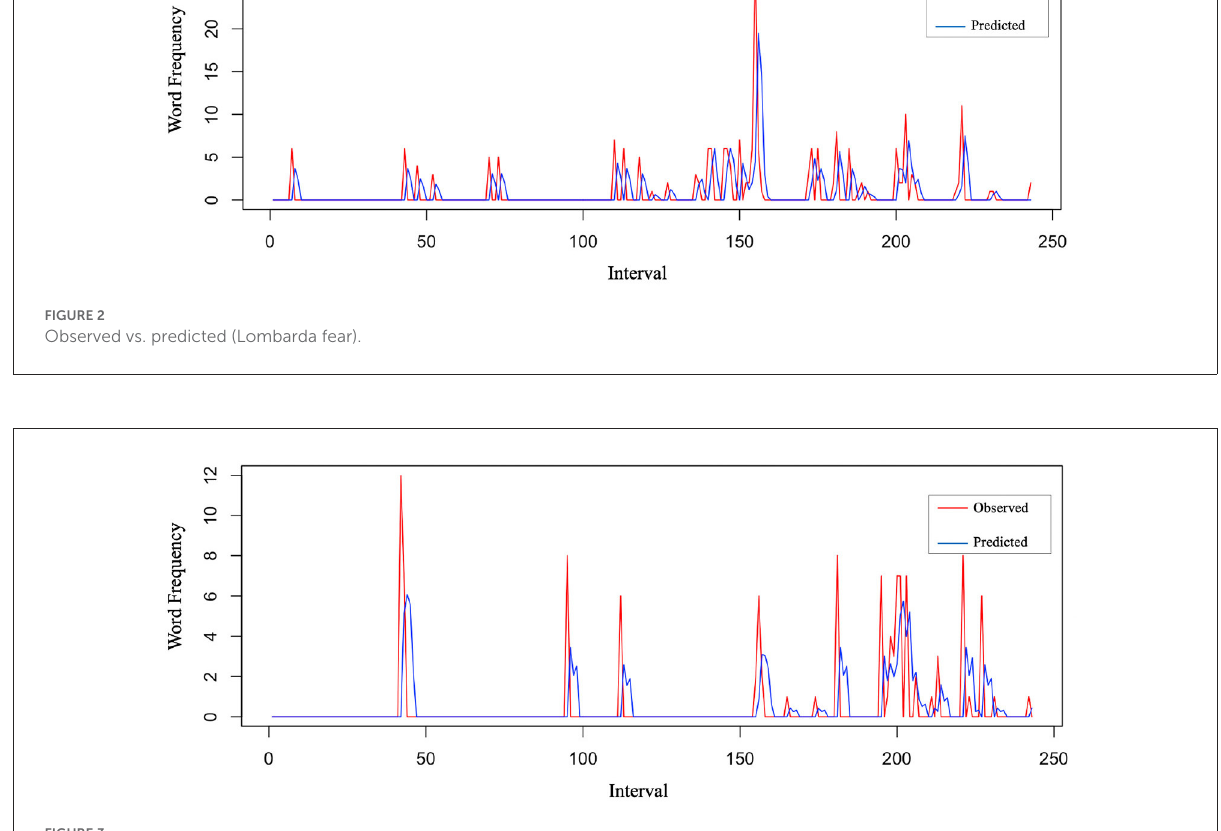
FIGURE3 Observed vs. predicted (Lombarda